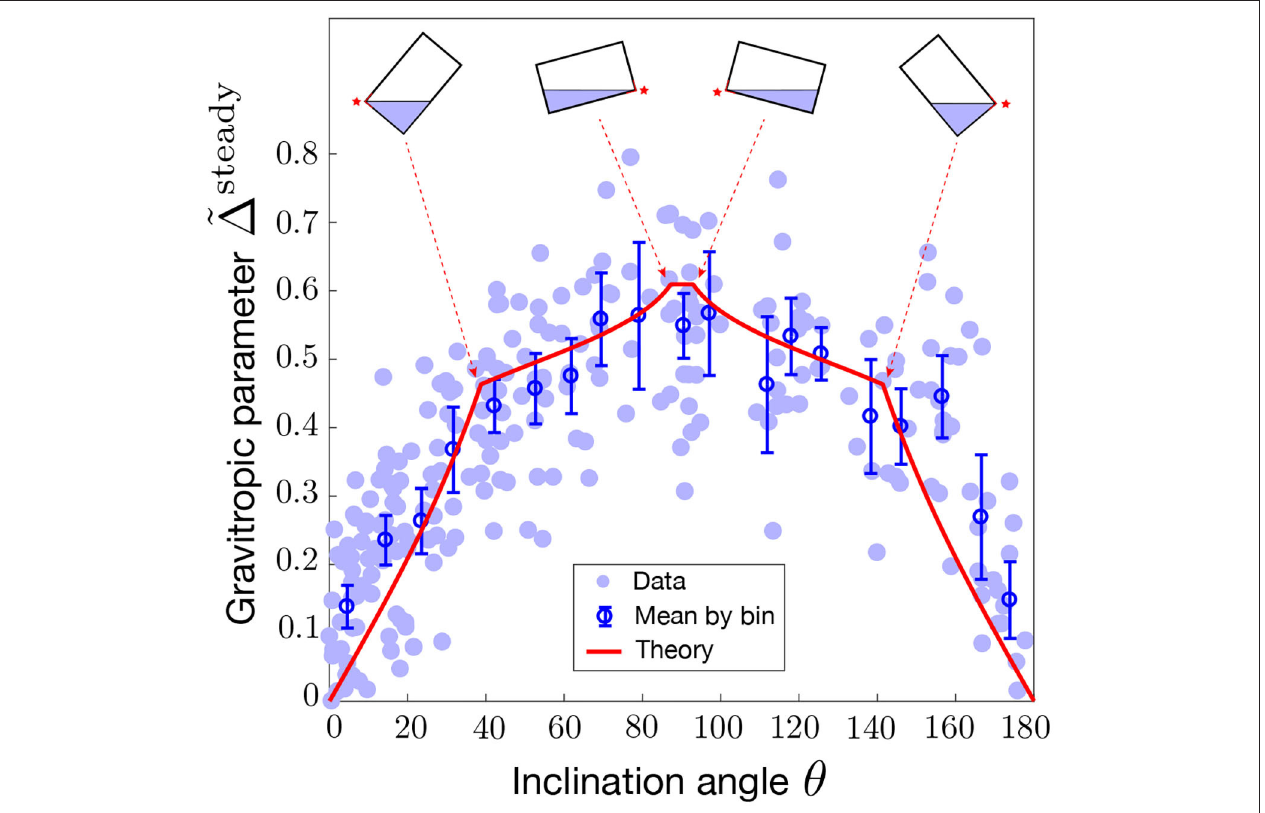
1 (limiting pool) and L-binding ≪